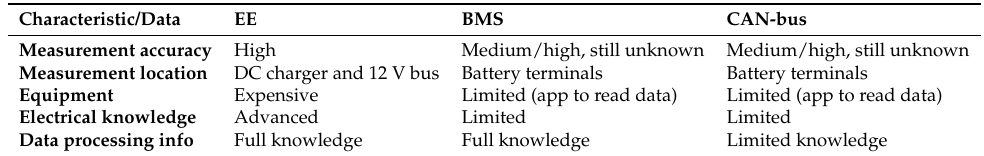
Table 7. Data collection